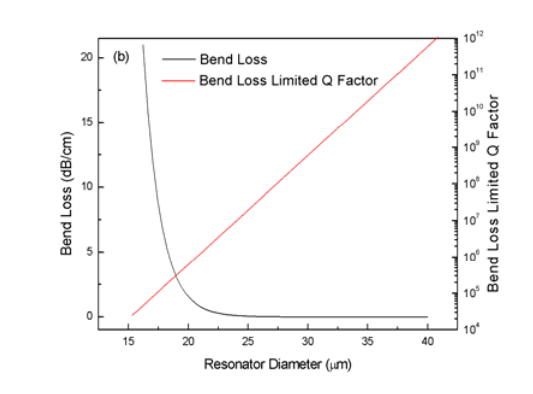
Figure 5. (a) Sensitivity versus resonator diameter. (b) Calculated bend loss and bend loss limited Q factor versus resonator diameter. Parameters n μ